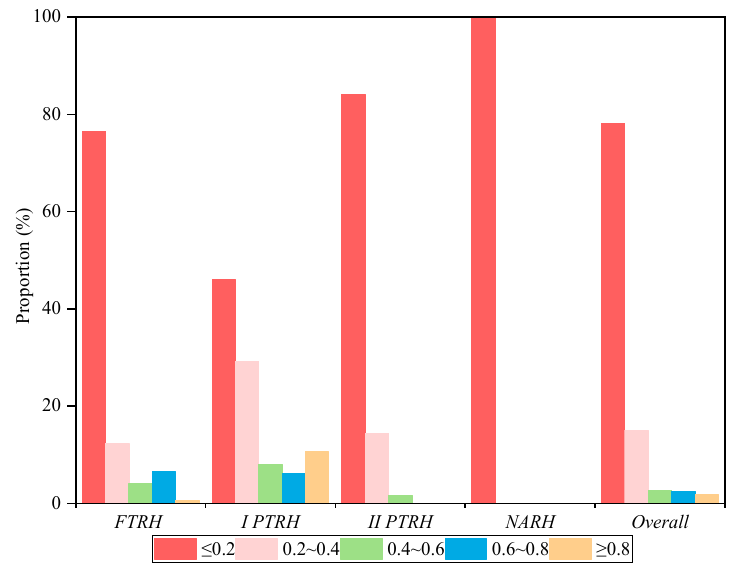
Figure 3. Distribution of CLUE within different types of rural households.